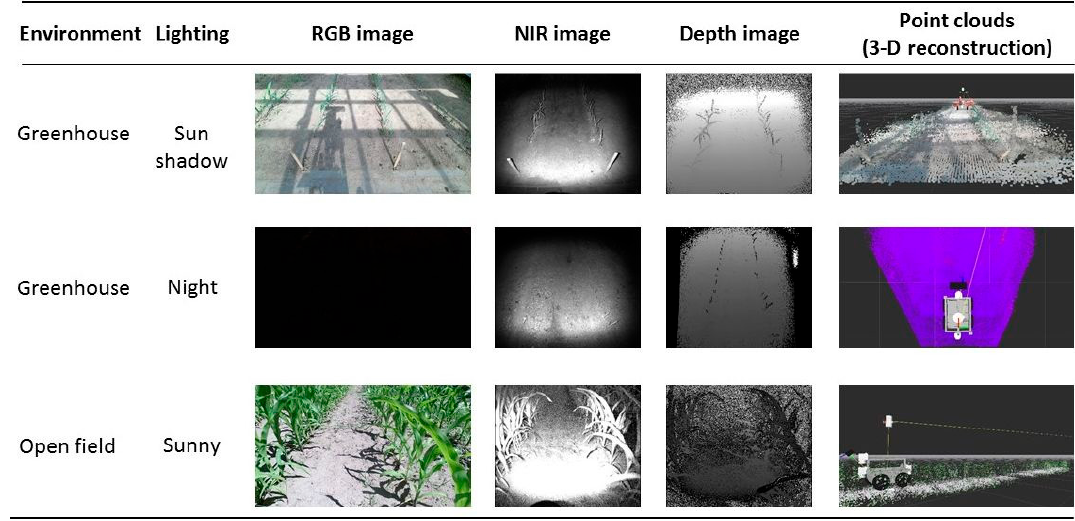
Figure 6. Reconstruction of maize plants using a CTC mounted on a field robot in different agricultural environments (reproduced from [114]).